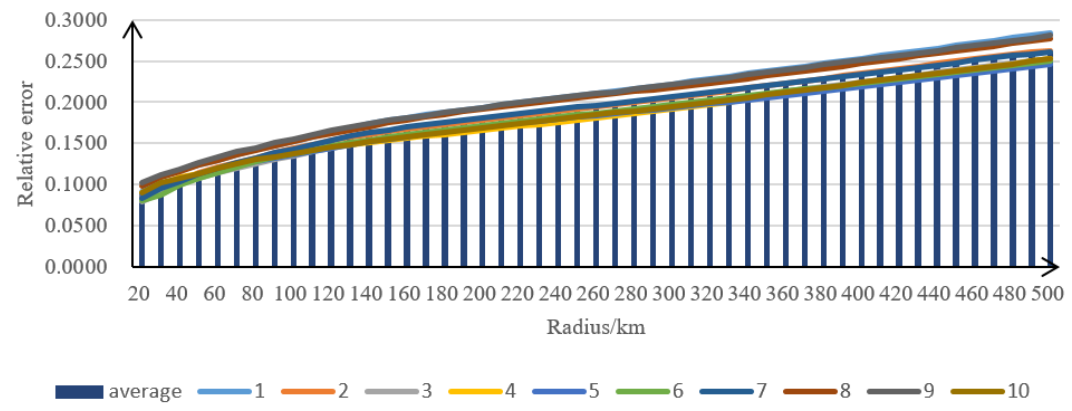
Figure 4. The average relative error of the generated aerosol optical depth (AOD) obtained from the 10 experiments with R values from 10 km to 500 km.